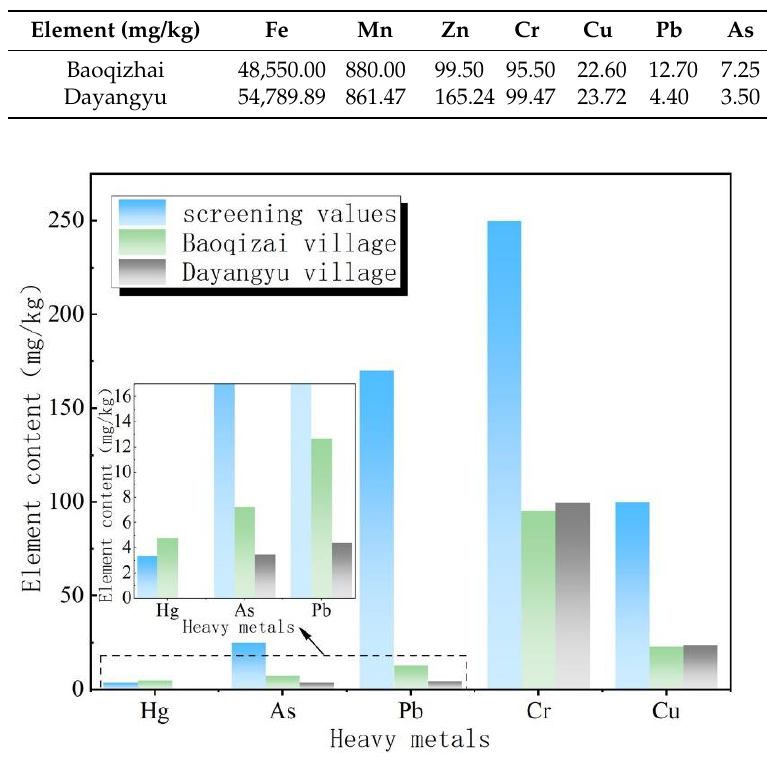
Figure 3. Comparison of the heavy metal content in the sample area with the screening value of agricultural land.